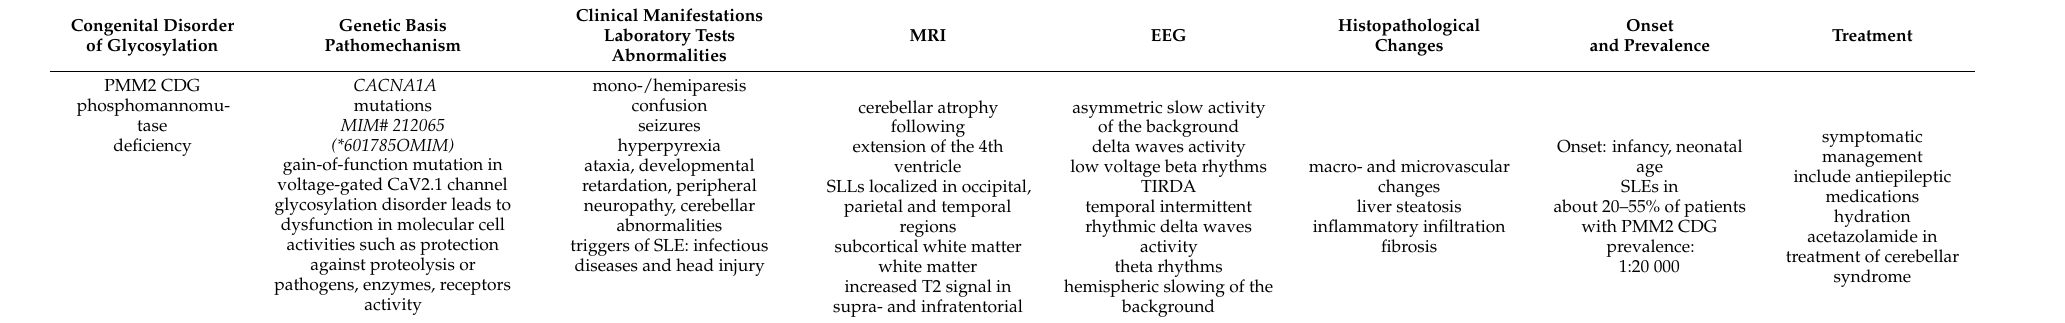
Table 5. This table shows characteristic features of congenital disorders of glycosylation—PMM2